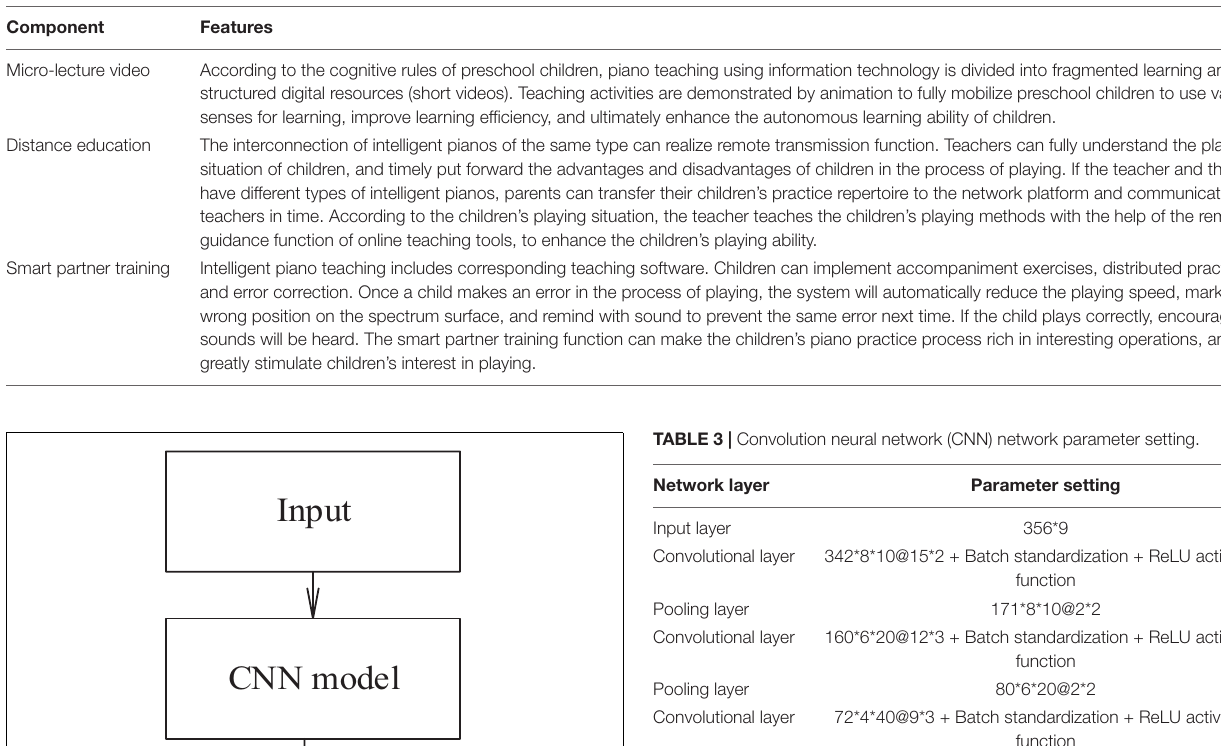
TABLE 2 | The components of intelligent piano online teaching.